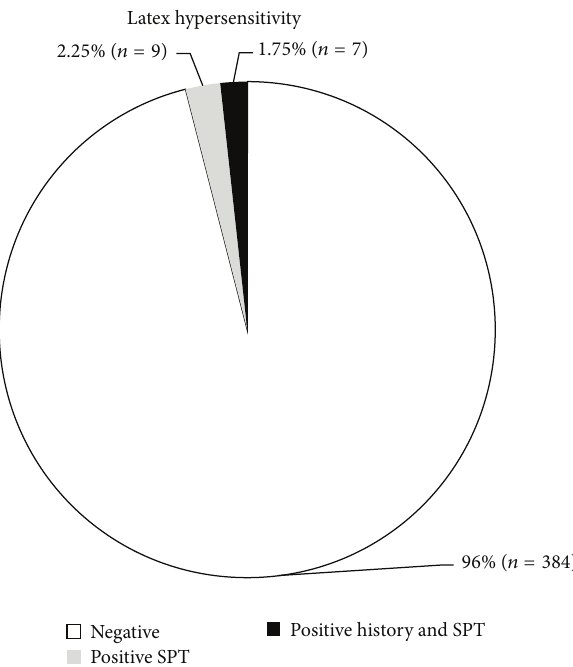
Figure 1: Latex sensitivity and SPT